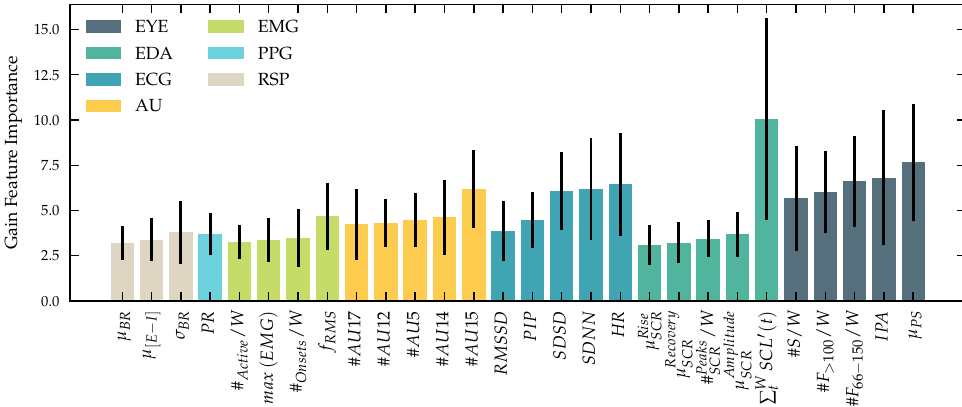
Figure 15. XGBoost provides among others gain as feature importance metric. We report the features with the five highest gain importance values, if available. Gain captures the feature importance by measuring the relative contribution of each feature in every tree to the final predictions, where higher values compared to other features indicate higher importance. Gain values are reported from models reported in Table 8 with bio-psychological features, action units and eye tracker-based features on combined (dual and single task load) with data from both experiments (10-fold-nested-